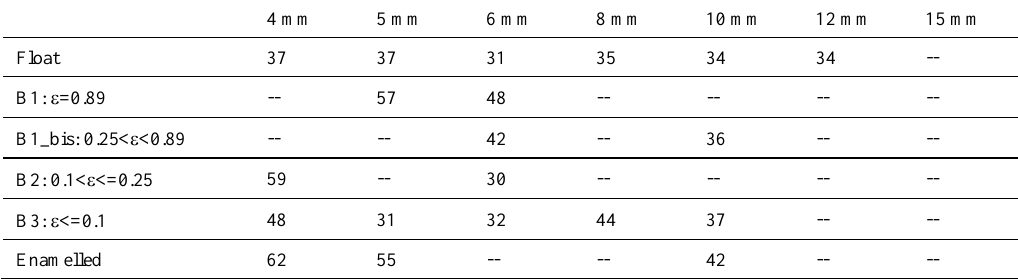
Table 10. Minimum SC values (MPa) vs conform FB for HS in SSV tested specimens